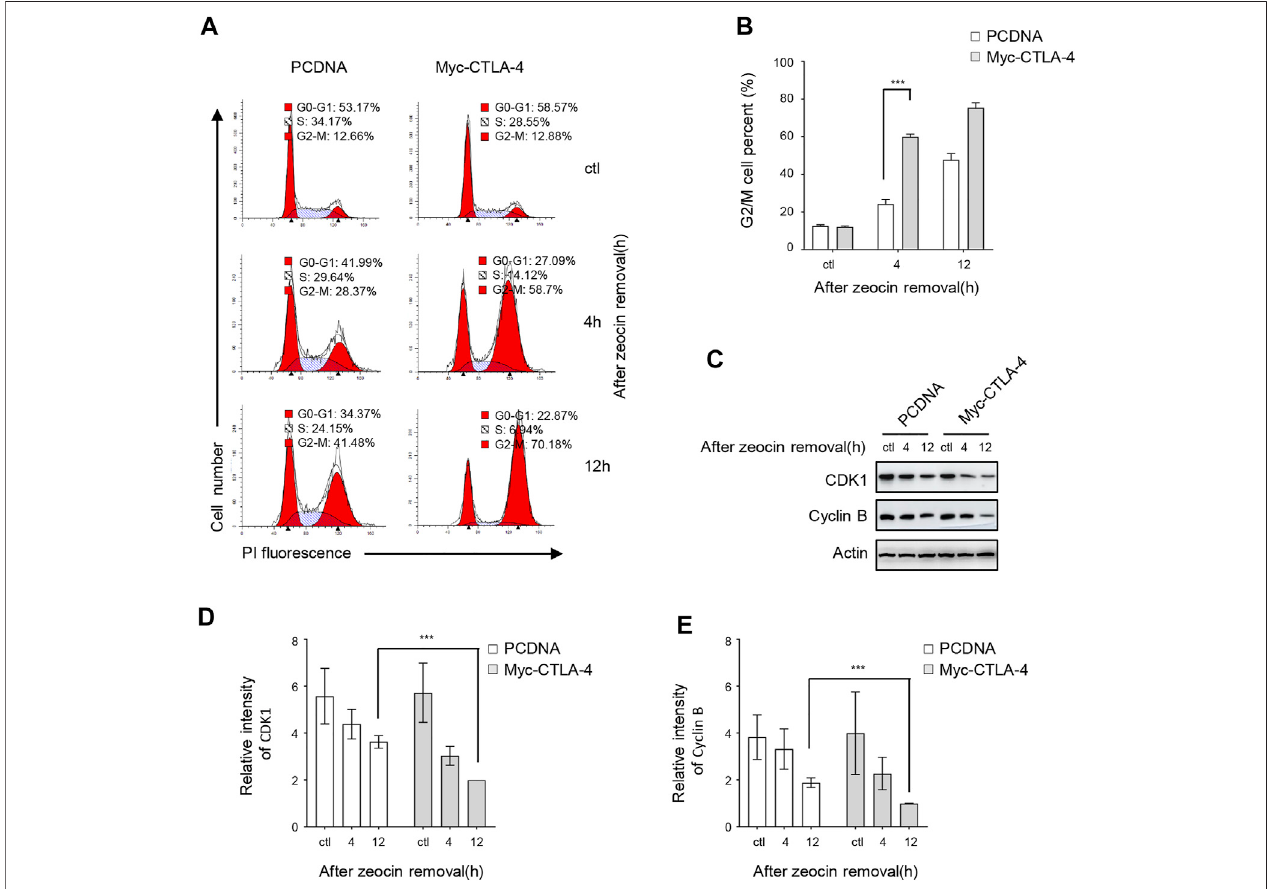
FIGURE5 | CTLA-4promotes zeocin-induced cell cycle arrest inthe G2/M phase. HeLacells were transfected withpcDNA and Myc-CTLA-4. After24 h, the cells wereexposedto500 μ g/mlzeocinfor1 handharvestedattheindicatedtimes. (A) Thecellcycledistributionwasanalyzedusing fl owcytometry. (B) Thepercentagesof cellsintheG2/Mcyclephasearedepicted. (C) LevelsofthecellcycleregulatoryproteinsCDK1andcyclinBweredetectedusingwesternblotting. (D,E) Quanti fi cationof immunoblots of CDK1 and cyclin B levels in the corresponding groups.